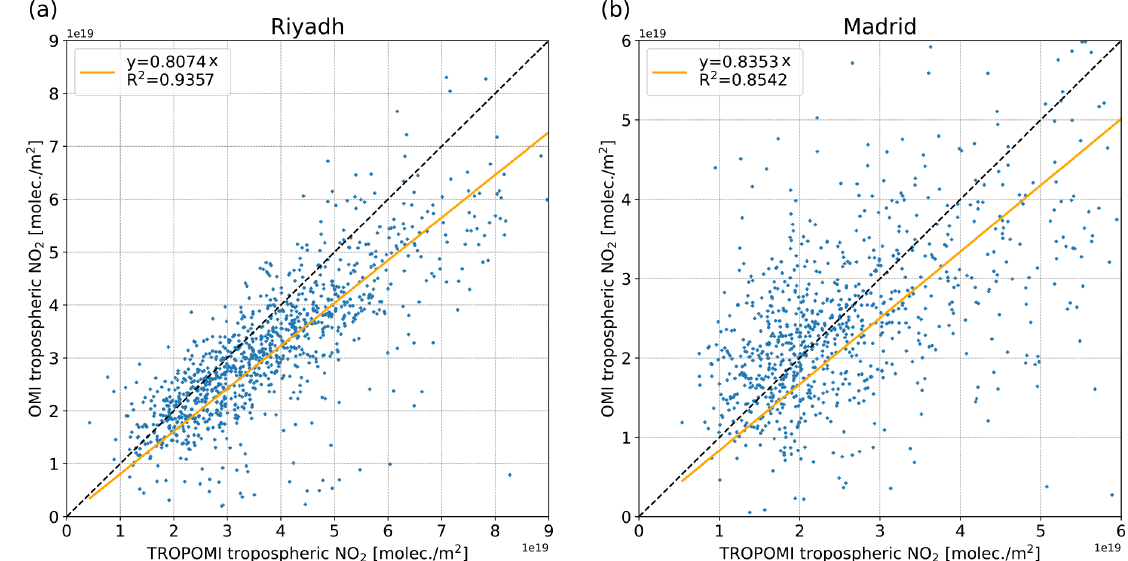
Figure A14. Correlation plot between the TROPOMI and OMI tropospheric NO 2 columns.